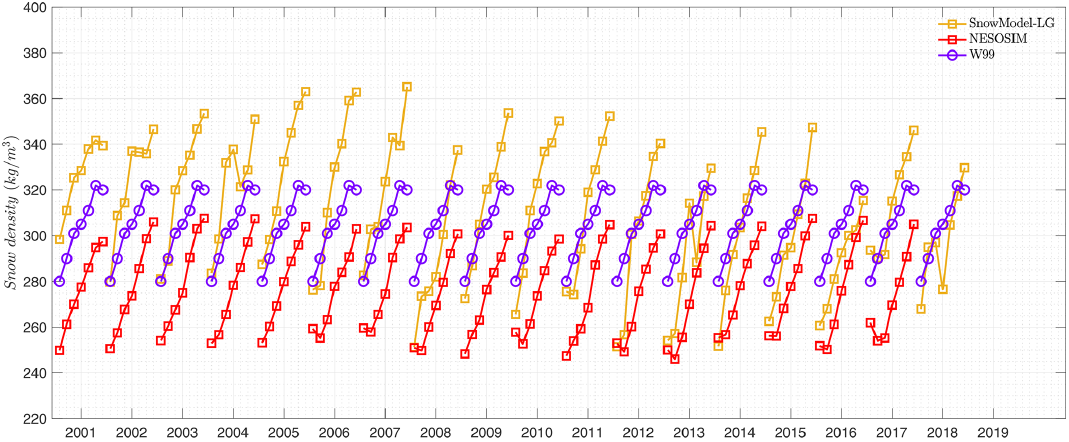
Figure 11. Time series of mean snow density (units: kgm − 3 ) within Arctic basin (common region in Fig. 1) comparison in SnowModel-LG, NESOSIM and W 99 since